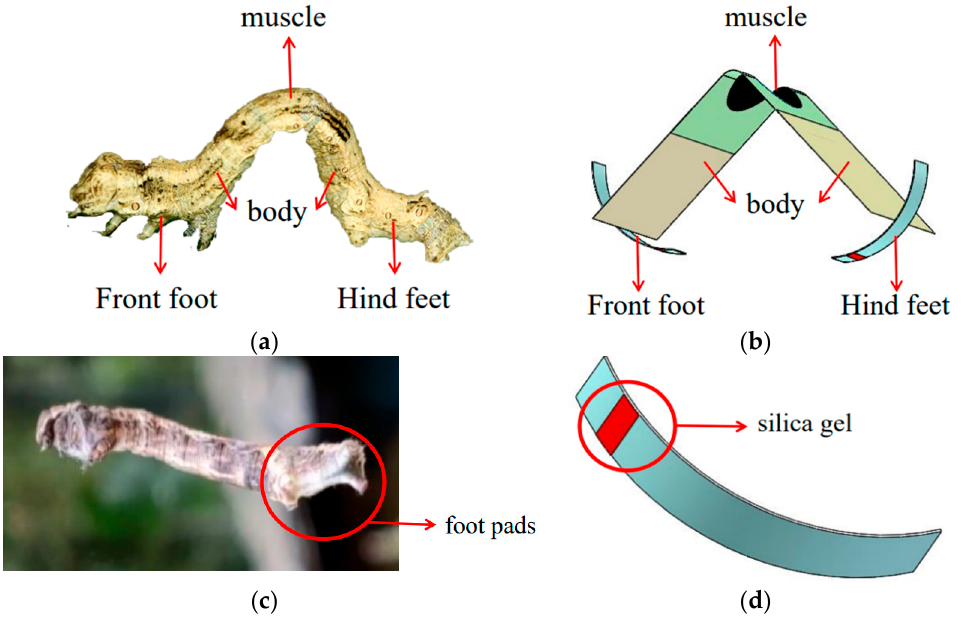
Figure 1. Structure model of bionic inchworm robot. ( a ) Structure of the inchworm; ( b ) Bionic inchworm robot structure; ( c ) The foot pads of the hind foot of an inchworm; ( d ) Silica gel at the bionic inchworm robot hind foot.